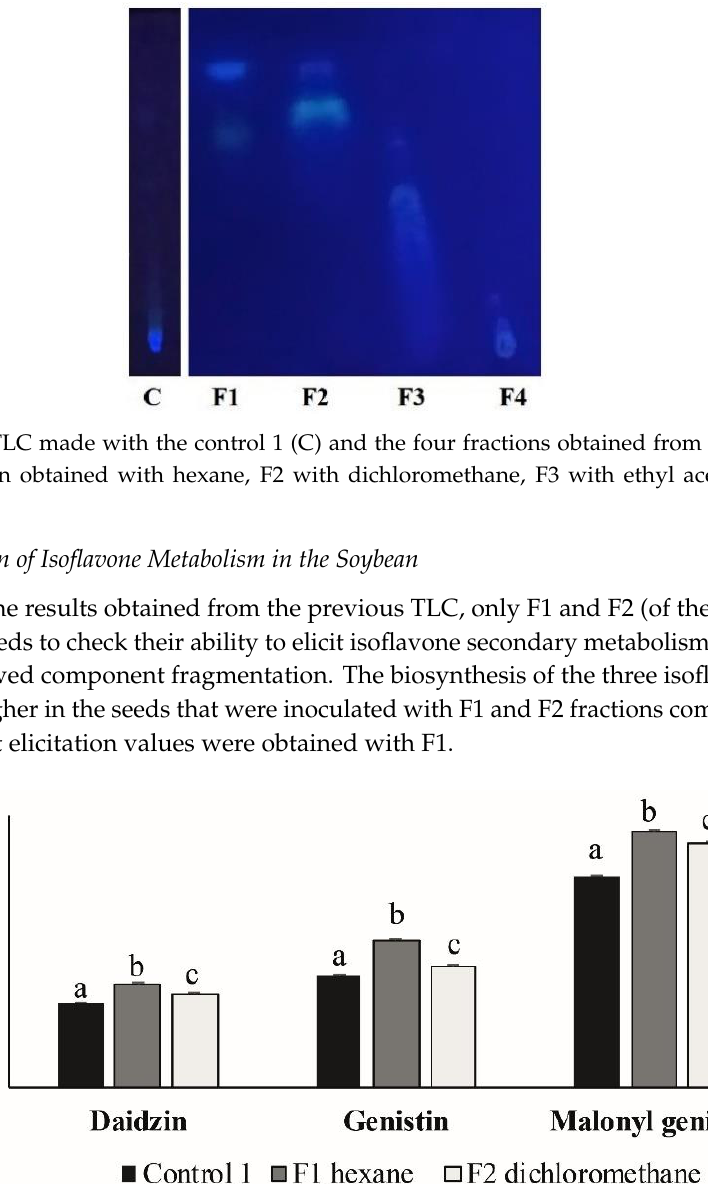
Figure 3. First TLC made with the control 1 (C) and the four fractions obtained from the fist VLC. F1 is the fraction obtained with hexane, F2 with dichloromethane, F3 with ethyl acetate and F4 with methanol.